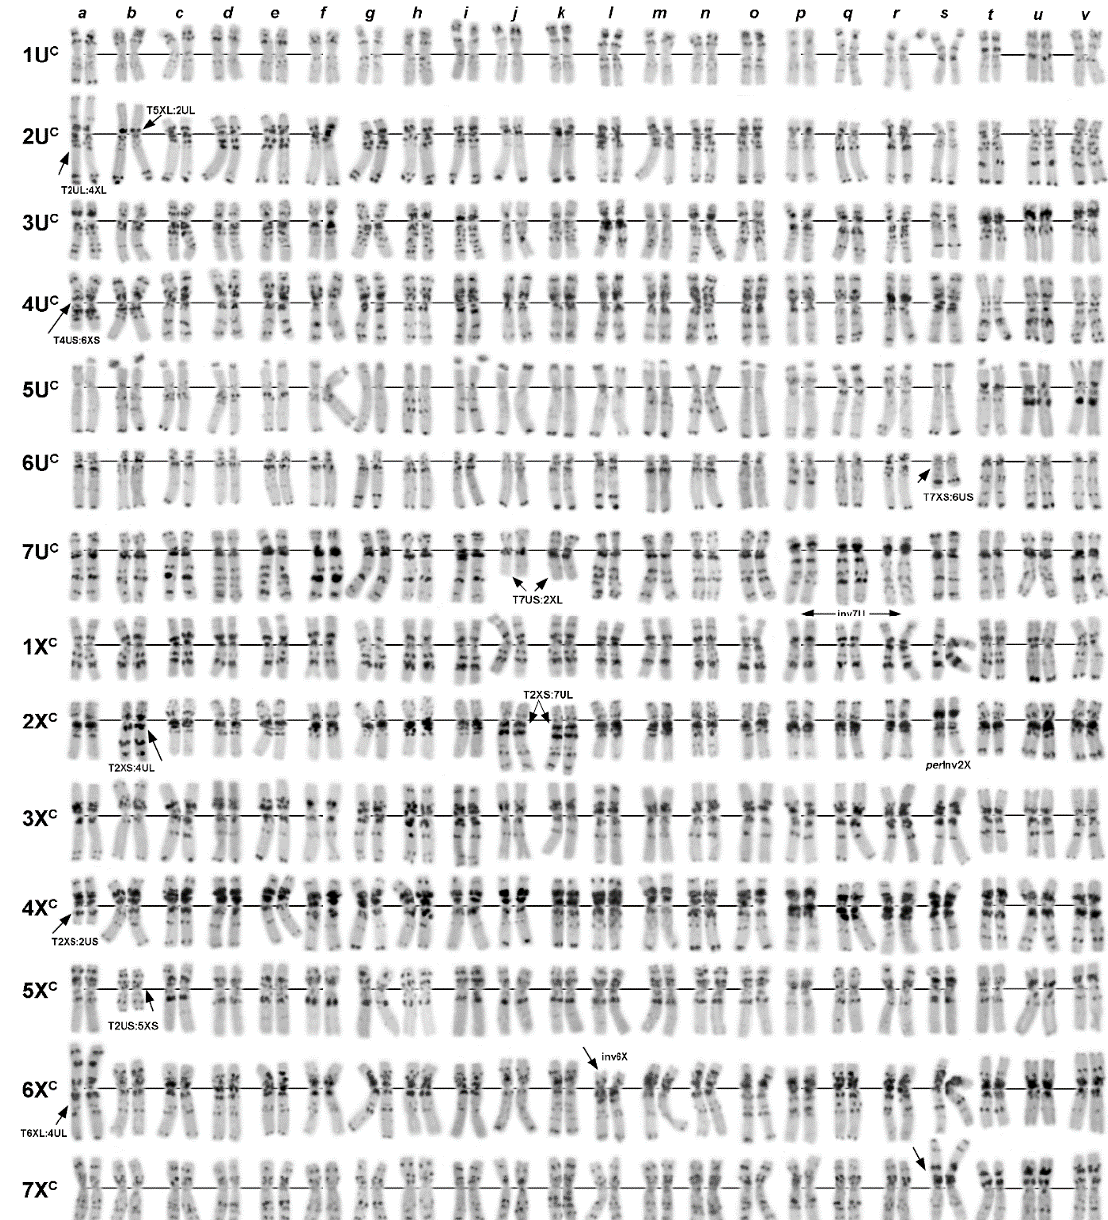
Figure 3. Polymorphisms of the C-banding patterns of Syrian and Lebanese accessions of Ae. columnaris ( a – s ) in comparison with Ae. neglecta ( t – v ): ( a )—K − 4372; ( b )—K − 4362; ( c )—PI 486196; ( d )—K − 2680; ( e )—PI 487198; ( f )—K − 4009 (Syria); ( g )—K − 4241a; ( h )—K − 4241b; ( i )—K − 4004; ( j )—K − 4003; ( k )—K − 4407; ( l )—K − 4406; ( m )—K − 4007; ( n )—IG 49067; ( o )—K − 4409 (Lebanon); ( p )—TX01; ( q )—Clae34; ( r )—AE 1521; ( s )—AE 1607a (unknown origin); ( t )—PI 564182 (Turkey); ( u )—K − 4233; ( v )—K − 4553 (Armenia). 1U c –7X c —chromosomes; translocated chromosomes are indicated with arrows and designated, respectively.